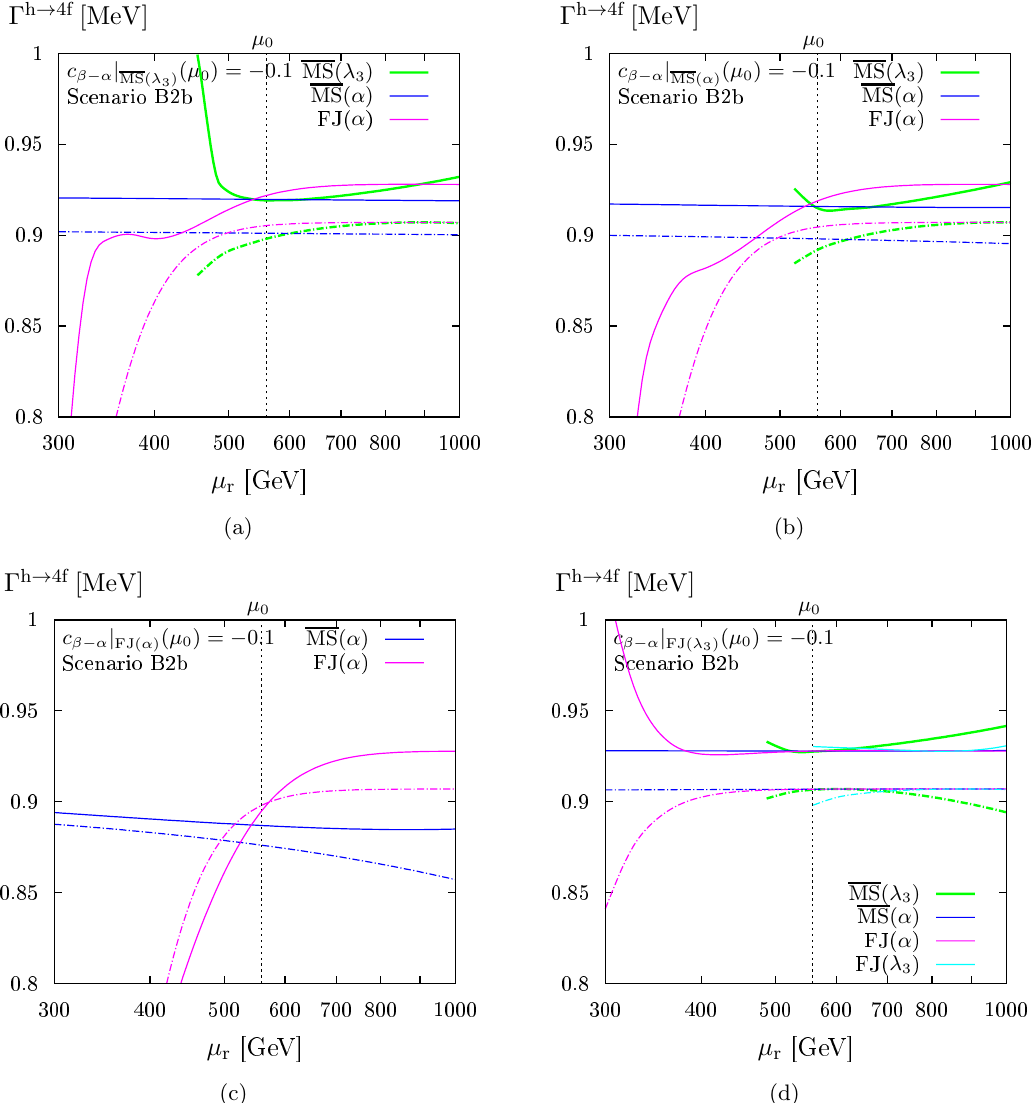
Figure 29 . The h 4 f width at LO (dashed) and NLO EW (solid) for scenario B2b in dependence ! of the renormalization scale. The panels (a), (b), (c), and (d) correspond to input values de(cid:12)ned in the MS( (cid:21) 3 ), MS( (cid:11) ), FJ( (cid:11) ), and FJ( (cid:21) 3 ) schemes, respectively. For each of them, the result is computed in all four di(cid:11)erent renormalization schemes after converting the input at NLO (also for the LO curves) and displayed using the colour code of (cid:12)gure 9. The FJ( (cid:21) 3 ) scheme is not de(cid:12)ned as target schemes due to the singular relation between (cid:11) and (cid:21) 3 . The dashed vertical line indicates the central renormalization scale (cid:22) r = (cid:22) 0